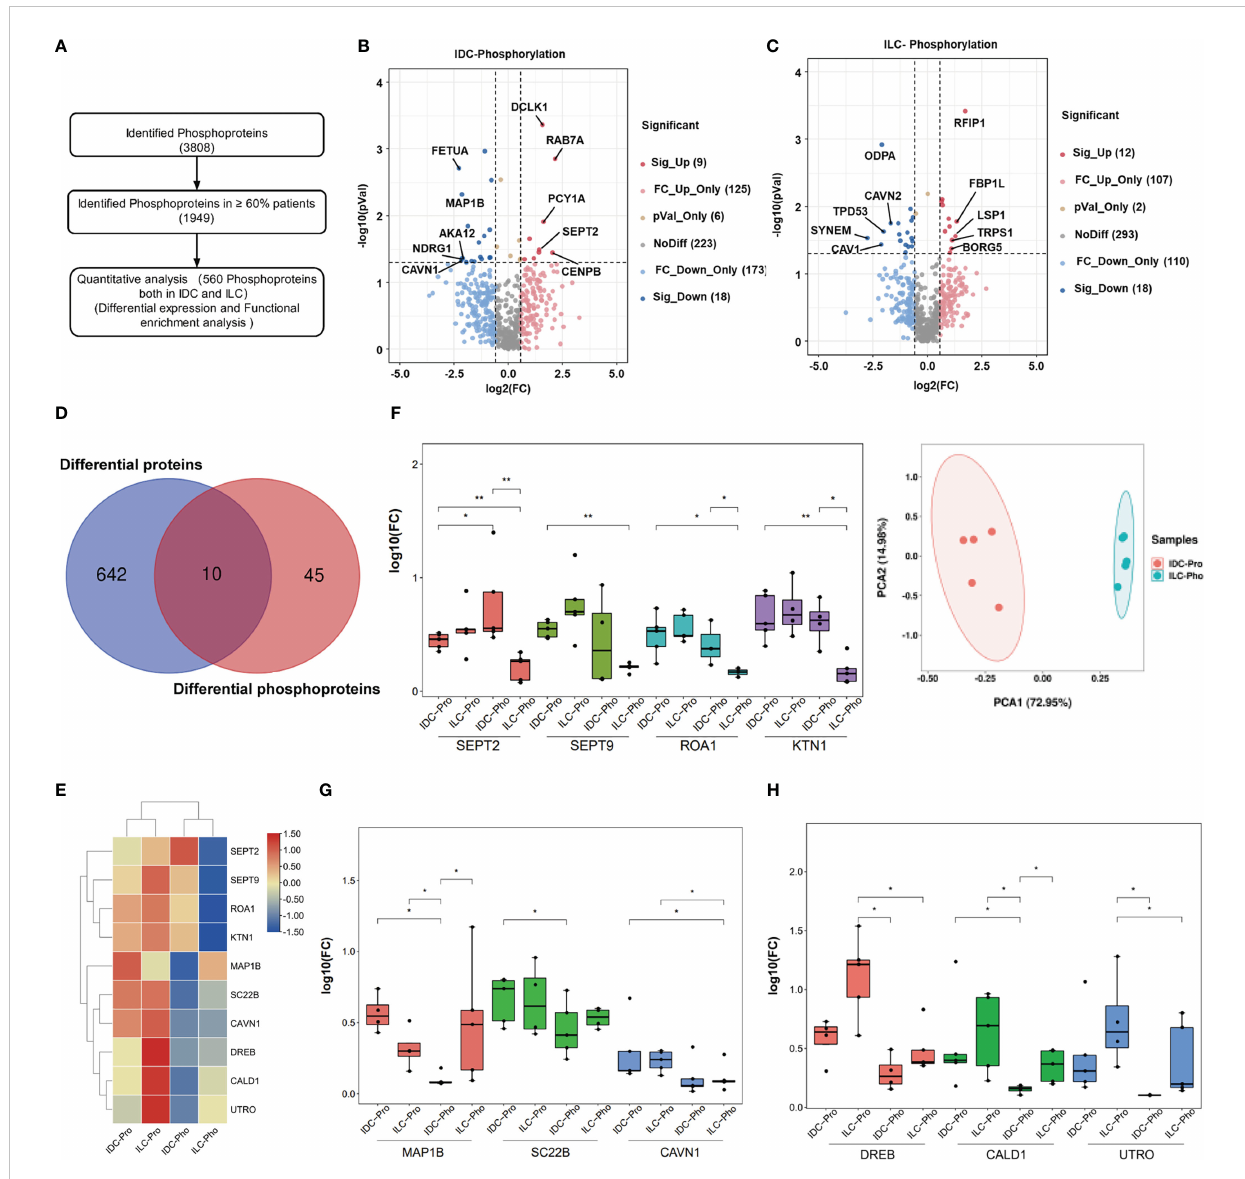
FIGURE 3 Phosphoproteome characterization of luminal A breast cancer. (A) Flowchart of data fi lter and normalization analysis of phosphoproteins identi fi ed from luminal A breast cancer. (B, C) Differential phosphoproteins between luminal A breast cancer tissues and their NATs. Red: Upregulated proteins, blue: Downregulated (P-value < 0.05 from t.-test and fold change > 1.50). (D) Overlap of differential proteins (Blue) and differential phosphoproteins (Red). (E) Protein expression levels and phosphorylation status of 10 selected phosphoproteins in IDC and ILC. (F) Left: Expression of SEPT2, SEPT9, ROA1 and KTN1 proteins and their phosphorylation status in IDC and ILC (P-value from Wilcoxon test). Right: PCA of these four proteins in 10 paired breast cancer tissues. Red, IDCs; green, ILCs. (G) Expression of the MAP1B, SC22B and CAVN1 proteins and their phosphorylation status in IDC and ILC (P-value from Wilcoxon test). (H) Expression of DREB, CALD1 and UTRO proteins and their phosphorylation status in IDC and ILC (P-value from Wilcoxon test). *, p<0.05; **,